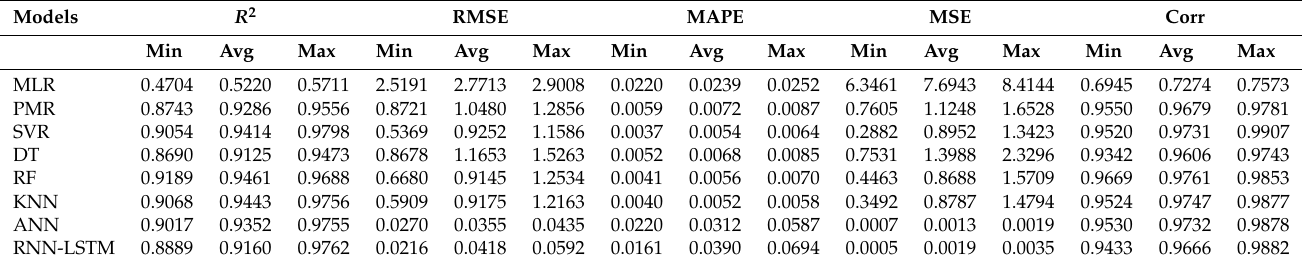
Table 1. Performance metrics’ values of all the ML-based models